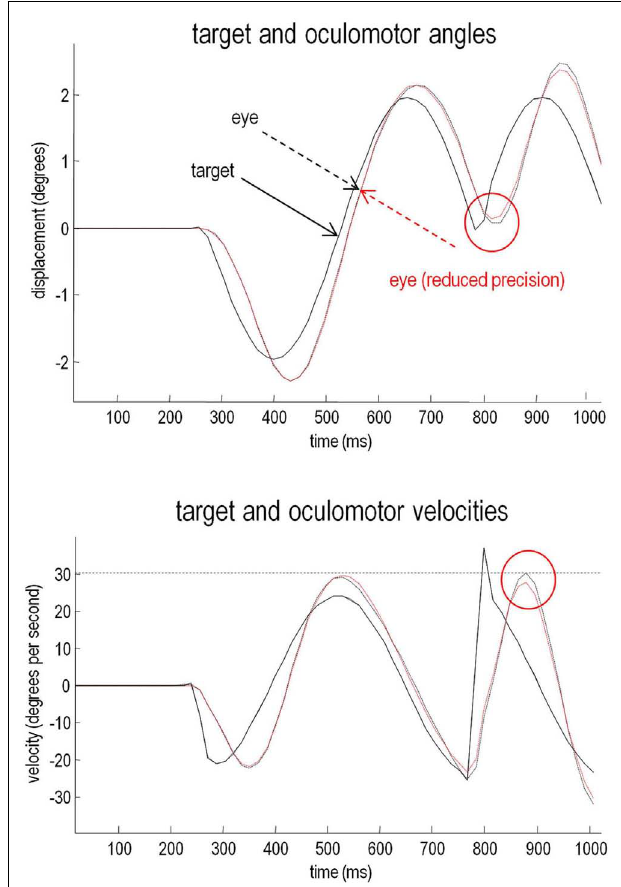
FIGURE 8 | Smooth pursuit with an unexpected trajectory change – with and without high-level precision: this figure reports the simulations of occluded periodic motion with a reversal in the direction of the trajectory at the beginning of the second cycle (plain black line) .The broken traces in black correspond to normal pursuit and the broken traces in red show the performance under reduced precision. Although the effect is small, reducing the precision about prior beliefs produces more accurate pursuit performance, both in terms of the displacement between the target and center of gaze and in terms of a slight reduction in the peak velocity during the compensatory eye movement (red circles).This illustrates the paradoxical improvement of performance that rest upon precise sensory information that cannot be predicted a priori (and is characteristic of syndromes like schizophrenia and